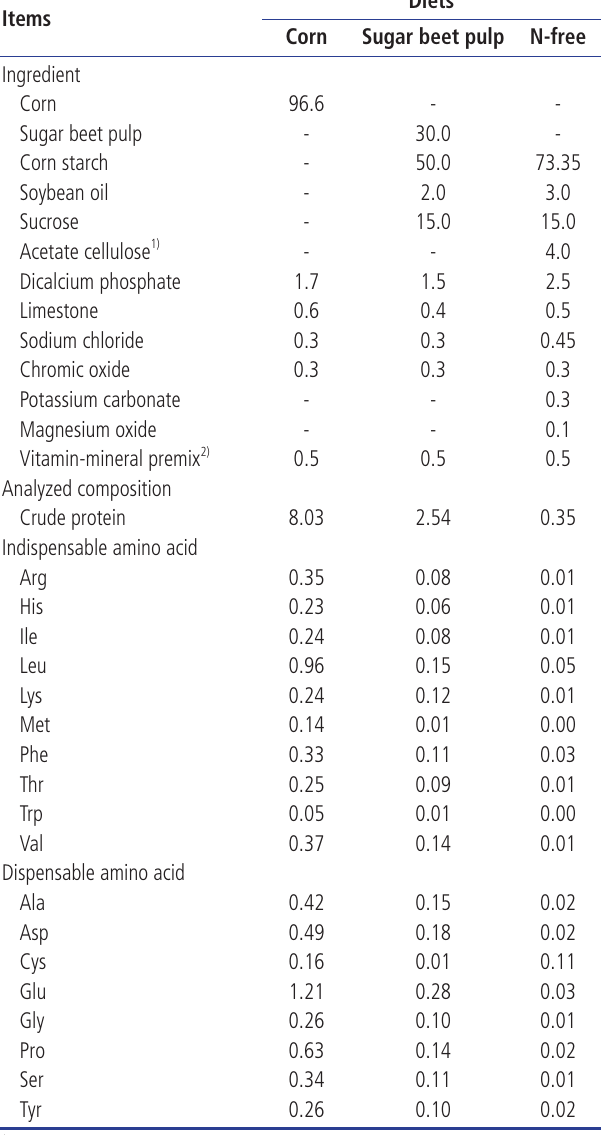
Table 3. The ingredient and analyzed composition of the experimental diets in Exp. 2 (%,